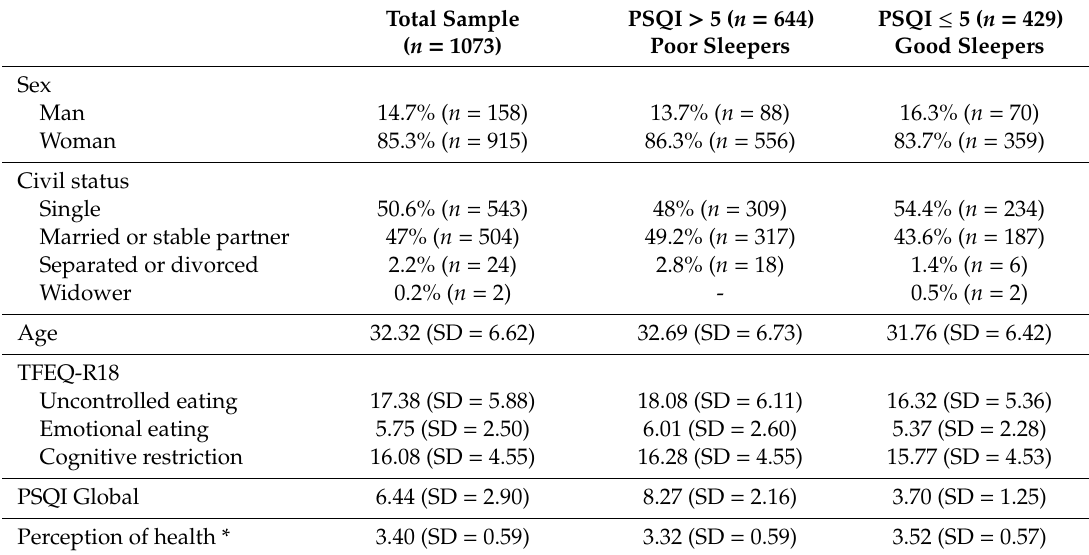
Table 1. Characteristics of the participants. Total sample and subsample attending to sleep di ffi